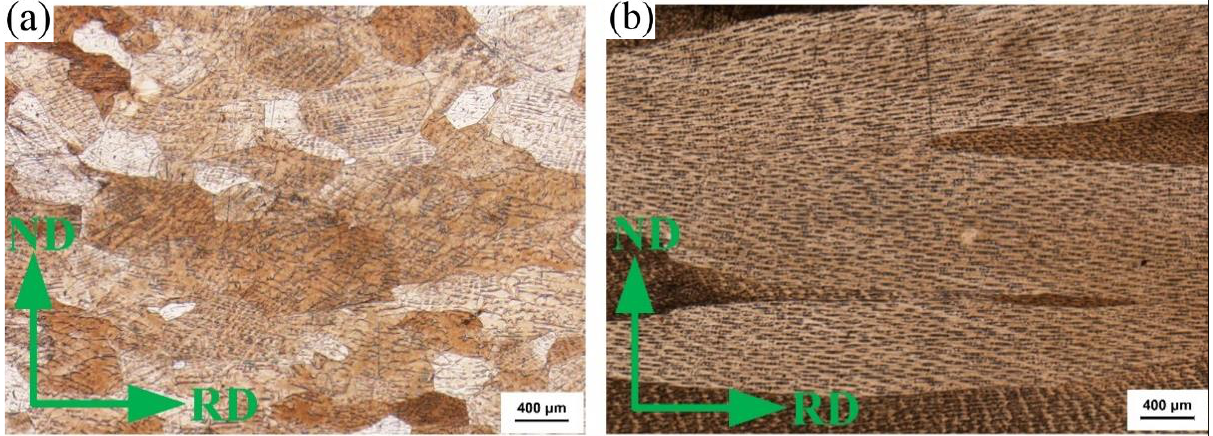
Figure 5. Metallography of the longitudinal section of cold rolled strip (ε = 25%). ( a ) EG strip and ( b ) CG strip.